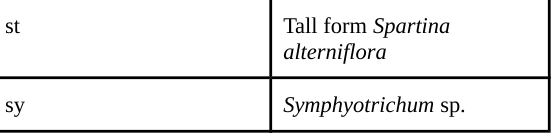
Table 2. List of plant species and land cover types recorded at the CZM Horseneck sentinel site in